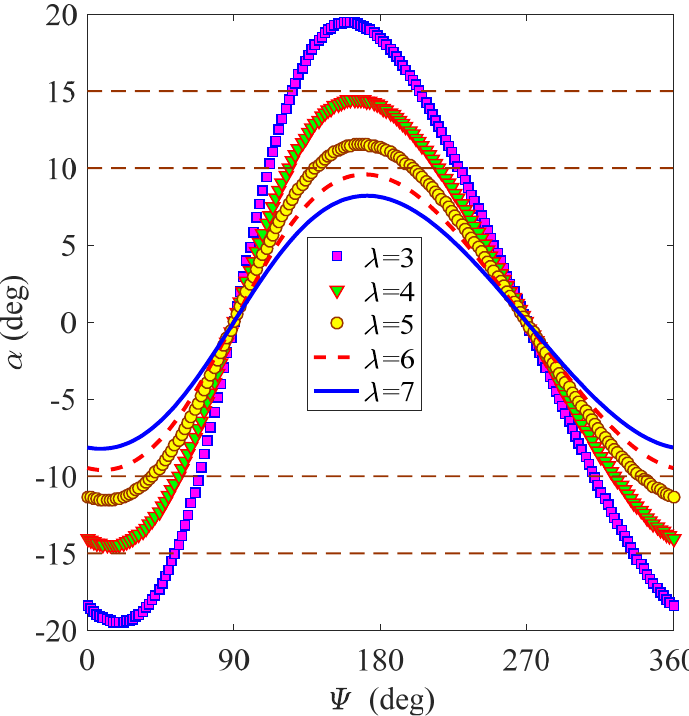
Figure 4. Angle of attack at each azimuth for different tip-speed